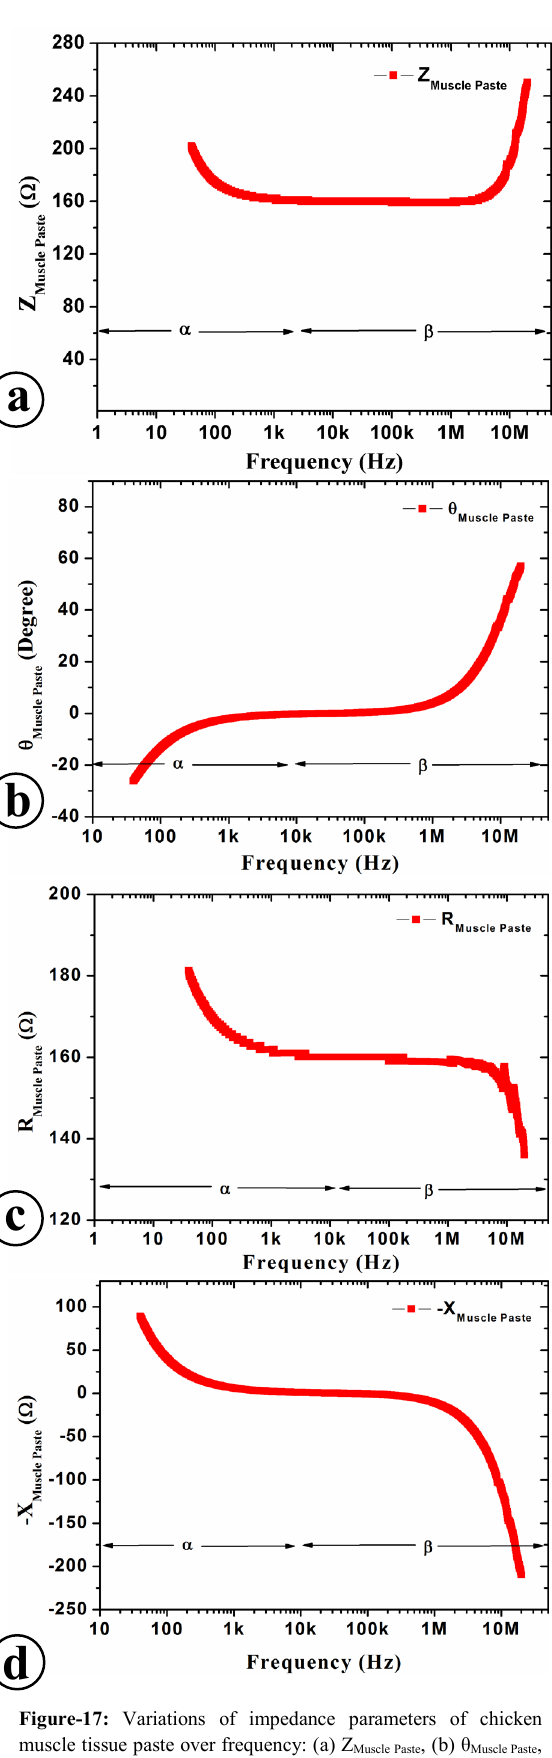
Figure-18: Variations of impedance parameters of chicken muscle tissue block over frequency: (a) ρ Muscle Block , (b) σ Muscle Block , (c) C Muscle Block , (d) ε rMuscle Block